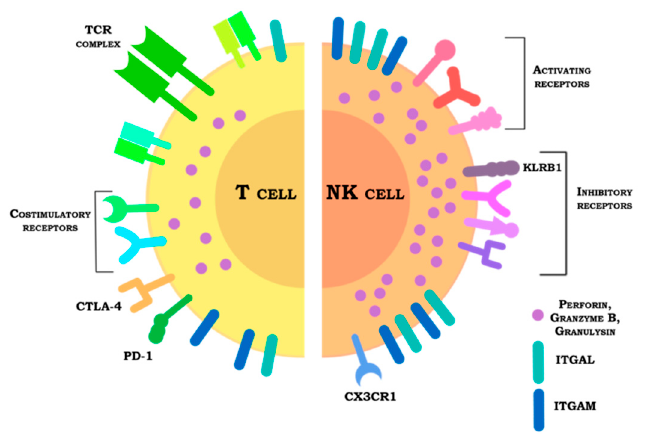
Figure 5. Schematic comparison of T and NK cells in the context of their use as CAR carriers. Unlike T cells, NK cells do not have TCR, but rather express a much greater variety of both activating and inhibitory receptors. The expression patterns of the inhibitory receptors differ between these cell types: in case of T cells, clinically relevant is expression of CTLA-4 and PD-1 receptors, for NK cells the potential checkpoint is KLRB1 receptor. NK cells express more perforin and granzymes and have a higher density of ITGAL and ITGAM on their surface, potentially making them the best cancer cell killers. For both T and NK cells, it is reasonable to express additional chemokine receptors to modulate taxis. modulate